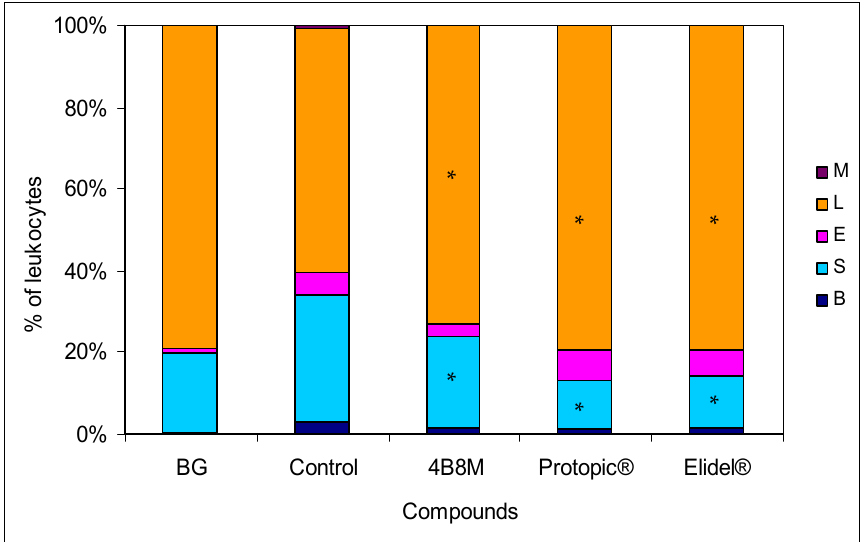
Figure 4. Effect of 4B8M and the reference drugs on peripheral blood cell composition of oxazolone-treated mice: the blood samples derived from mice bled 24 h after application of the compounds. The blood smears were stained with Giemsa and May-Grünwald reagents and evaluated at 1000× magnification. Up to 100 cells were counted per preparation. The results were presented as a percentage of main cell types in the peripheral blood: mature neutrophils (segments, S), neutrophil precursors (bands, B), eosinophils (E), lymphocytes (L), and monocytes (M). Mean values for each group are presented. * Control vs. compounds p < 0.05 (ANOVA).